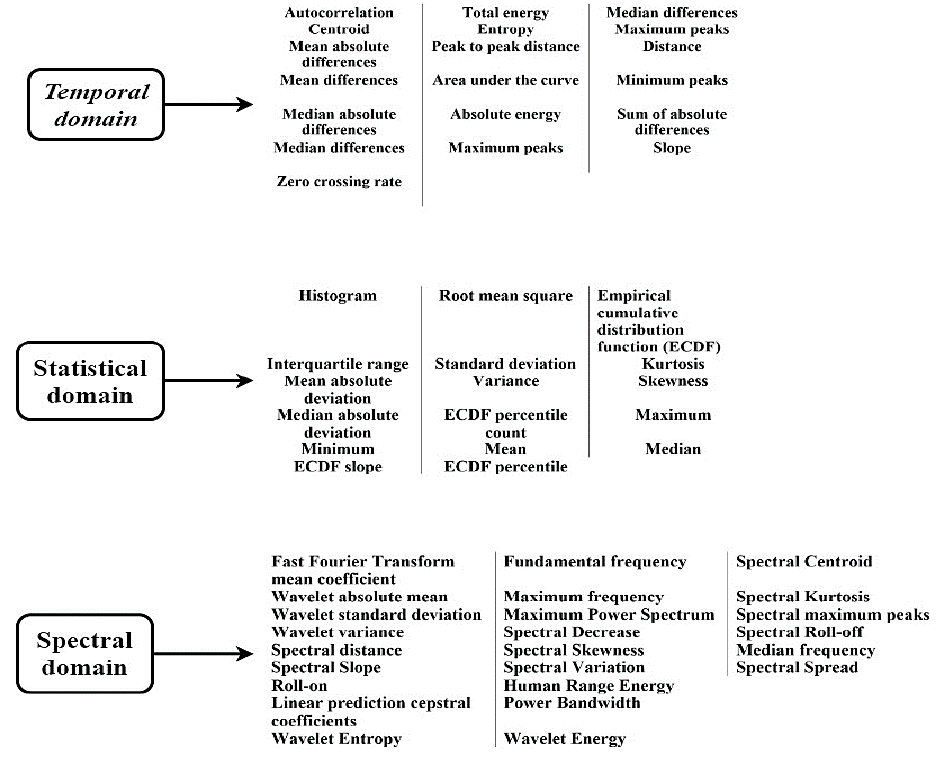
Figure 9. Extracted features using the TSFEL algorithm [37].